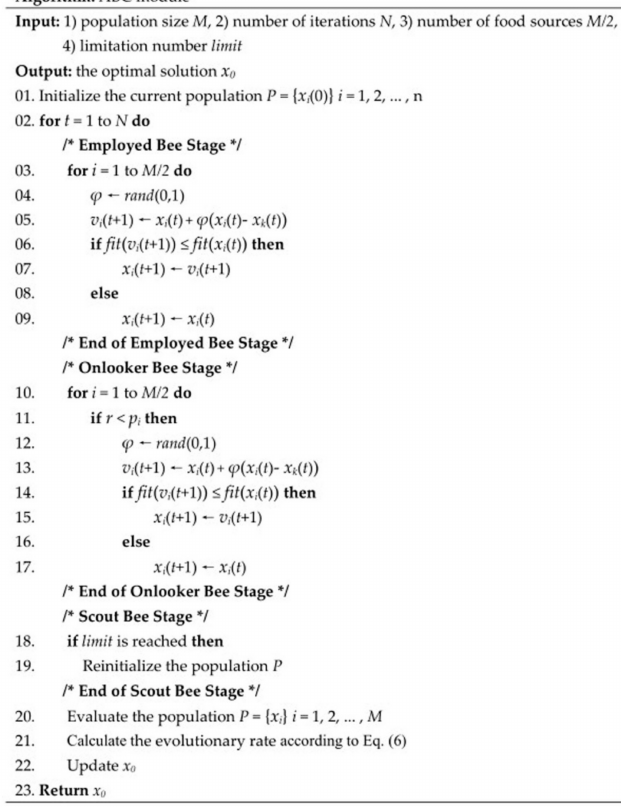
Figure 5. Pseudocode of ABC